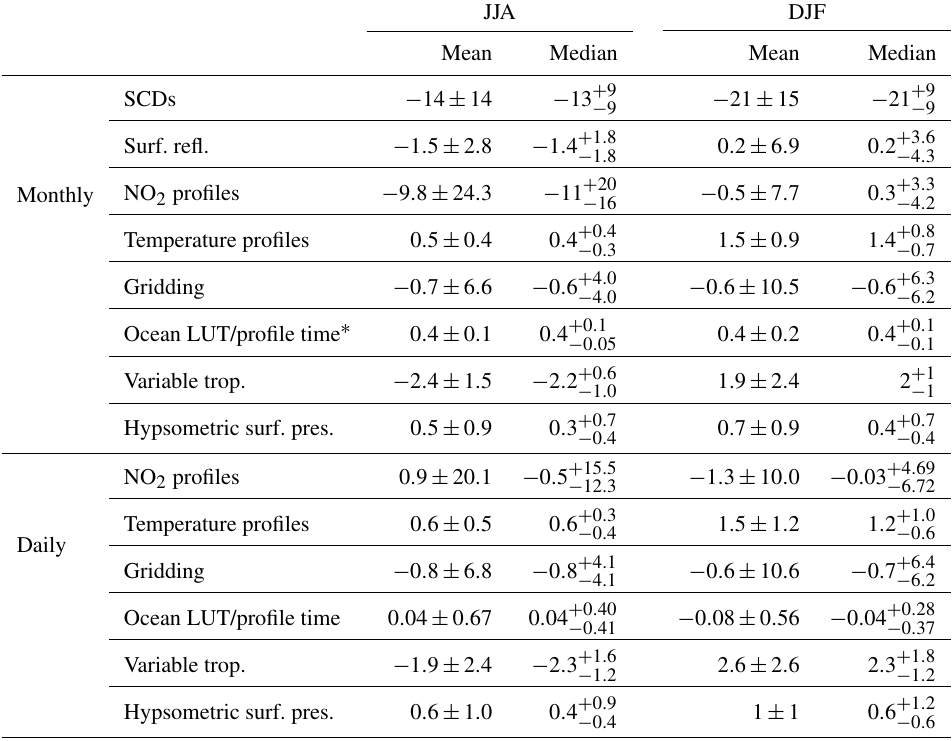
Table 3. Percent differences in averaged NO 2 VCDs for each increment. Means are given with 1 σ uncertainties; medians are given with uncertainties as the distance to the upper and lower quartiles. “Monthly” and “Daily” in the first column indicate which subproduct is considered (Sect. 2.6). “Ocean LUT” refers to the ocean surface reflectance LUT. Outliers were removed before calculating these statistics. JJA